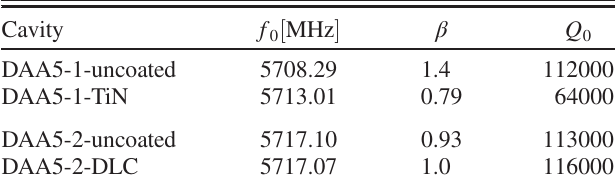
TABLE I. The effect of TiN coating and DLC coating on the Q-value of the five-cell DAA cavity (DAA5). Cavity f 0 ½ MHz (cid:2)